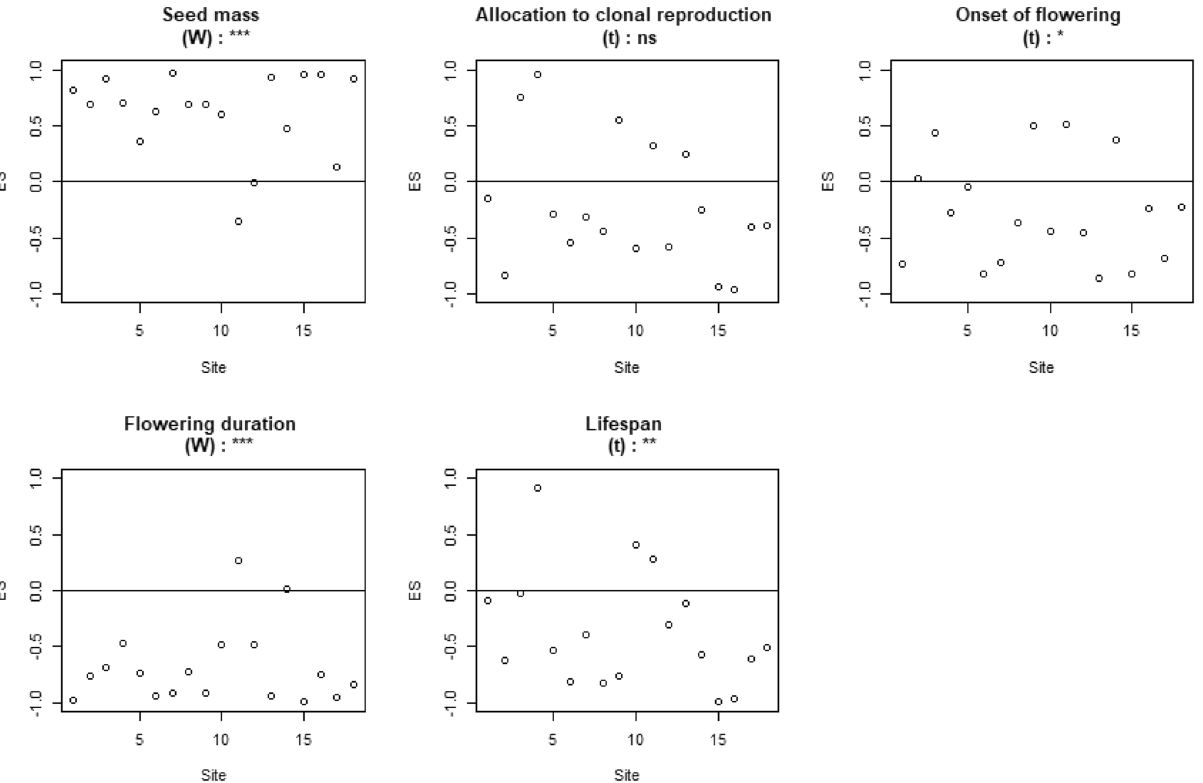
Figure 3. Effect size (ES) of grassland plant assemblages obtained using the “species occurrence rate model” (NM2) for each of the five traits: seed mass, allocation to clonal reproduction, onset of flowering, flowering duration and lifespan. Significance levels (***p < 0.001, **p < 0.01, *p < 0.05) and non-significance (ns) of the Wilcoxon tests (W) or Student’s t tests (t) are presented on top of each graph. Df = 14. This figure was created using R Software 81 (v. 4.02, https ://www.r-proje